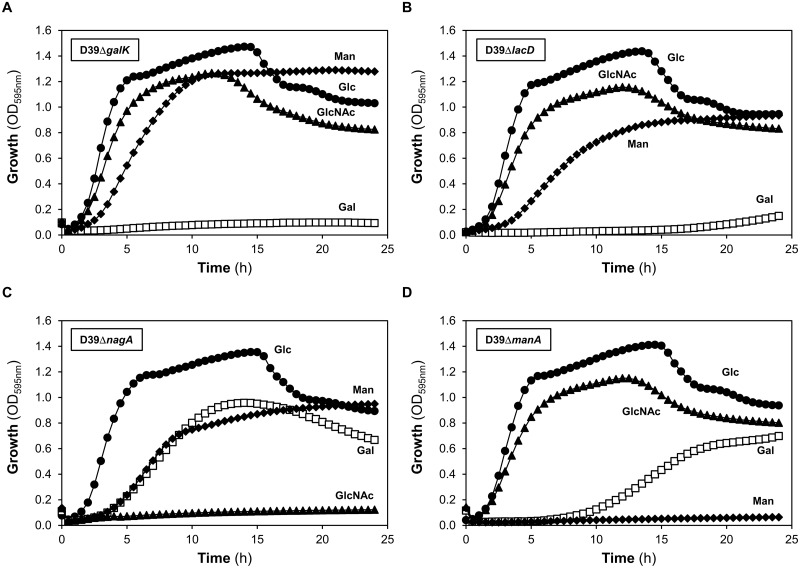
Growth profile of D39 sugar-specific mutants.Growth phenotypes of (A) D39ΔgalK, (B) D39ΔlacD, (C) D39ΔnagA and (D) D39ΔmanA. Growth was performed in CDM supplemented with galactose (Gal), N-acetylglucosamine (GlcNAc), mannose (Man) or glucose (Glc), using the 96-well microplate reader. Symbols: (closed triangle) GlcNAc; (closed diamond) Man; (open square) Gal and (closed circle) Glc.